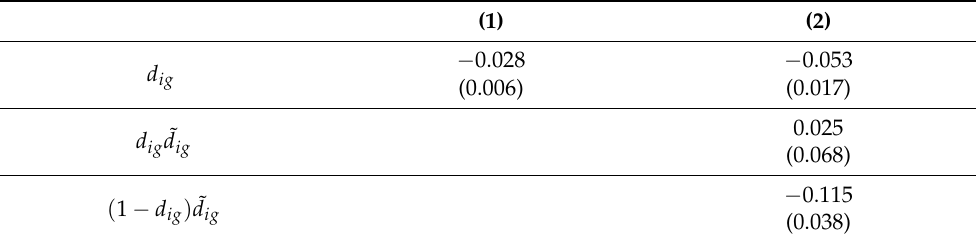
Table 3. Estimates from